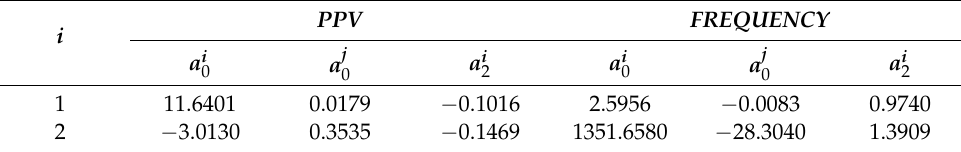
Table 8. Consequent parameters of the PPV and FREQUENCY